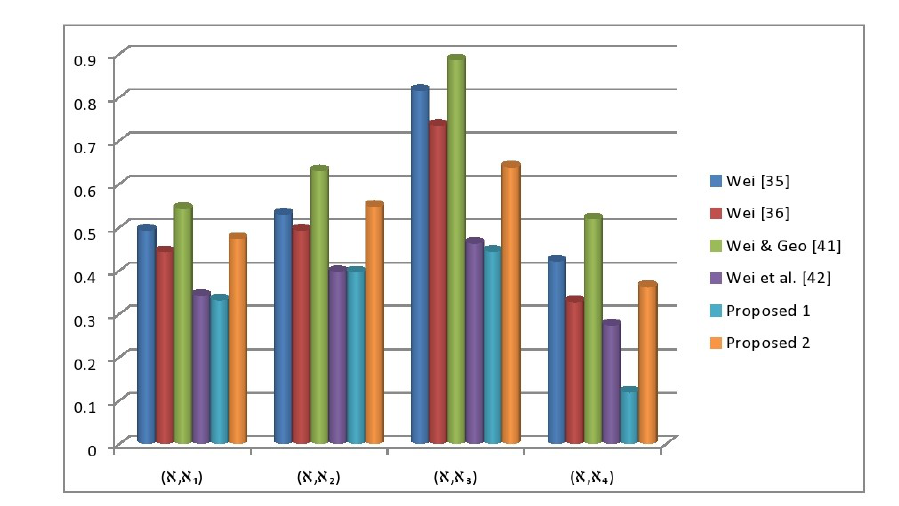
Figure 2. Comparative Study of the